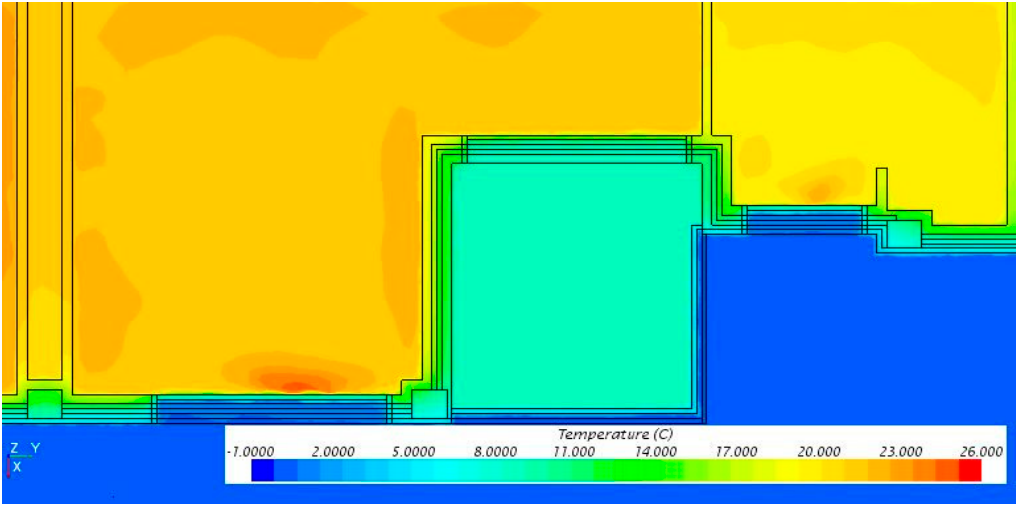
Figure 9. Horizontal section detail, showing influence of the balcony on floor 2, at the height of 1.7 m.